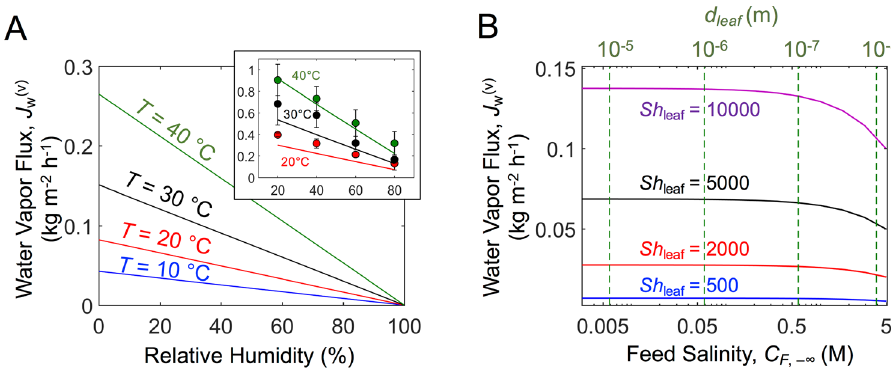
Figure 2. Evaporated water flux from leaves. ( A ) Evaporative water flux at leaves for different relative humidities and temperatures of the environment. Air velocity ( U ∞ ) of 1.4 m s −1 (= 5 km h −1 ) is considered. (Inset) Experimental measurement (symbols) and model prediction (Eq. (4), solid lines) of water vapor fluxes for the previously reported lab-scale artificial tree 33 . ( B ) Evaporative water flux for different solute concentrations in the feed water on the ground (at root) and mass transfer coefficients. Here, NaCl is assumed as feed solute, and relative humidity ( RH ) of 0.4 and T = 30 °C are considered. The dotted lines indicate the maximum treatable feed soulte concentration, which is determined by the corresponding leaf pore diameter, d leaf (Eq. 1), marked on the upper x -axis. For all calculations, leaf surface porosity (ε) of 0.4, length scale of the leaf surface ( L ) of 50 m, and feed flow velocity ( U −∞ ) of 1 m s −1 are considered. As a reference, U ∞ = 1.4 m s −1 and L = 50 m correspond to Sh leaf =